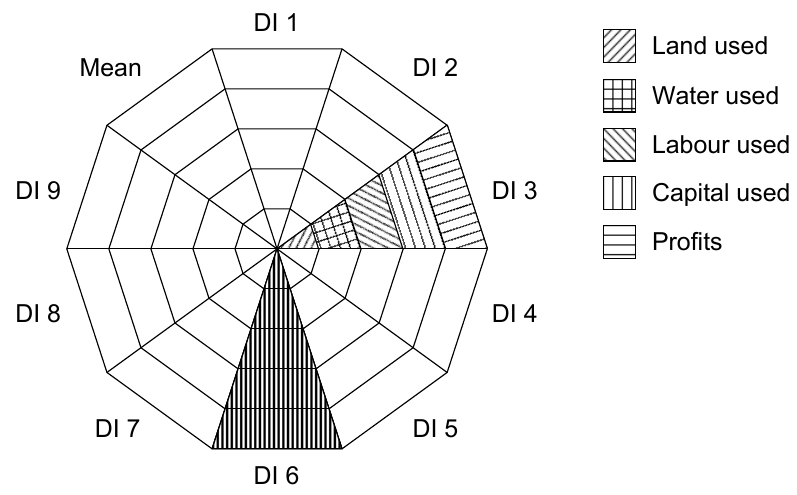
Figure 5. Interpretation of radar plots (Figures 6 and 7) showing profits and seasonal use of resources for each scenario at a situation of resource distribution. Each ring represents a resource index organised as follows (from inside to outside): Land, water, labour and capital used, and profit; each slice corresponds to a decile of water availability